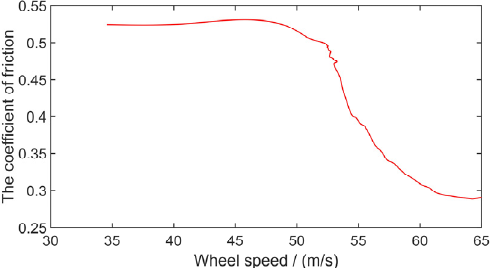
Figure 10. Relationship between the wheel speed and the friction coefficient of a C/SiC brake disc.